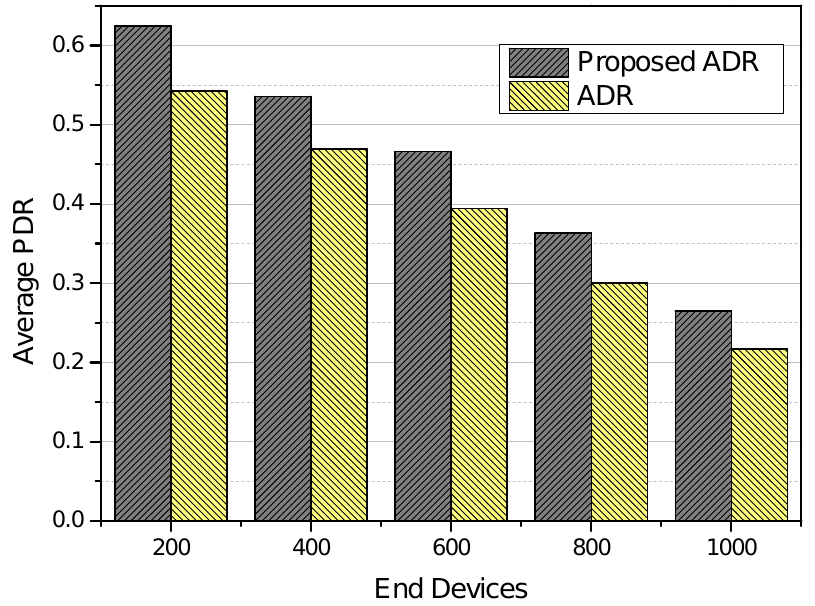
Figure 3. Average Packet Delivery Ratio of the Proposed ADR and ADR.